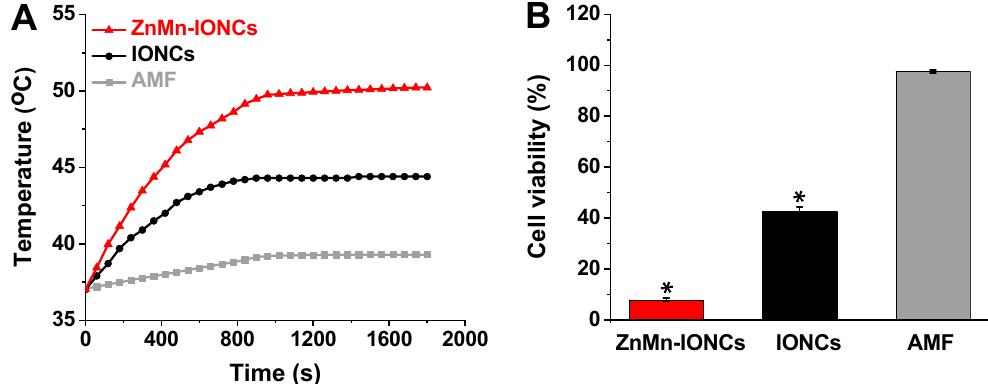
Figure 6. ( A ) Representative heating curves of DU145 cells treated with medium only (AMF), ZnMn-IONCs (50 µ g of Fe / mL) and IONCs (50 µ g of Fe / mL) for 24 h, and exposed to AMF (420 kHz, 26.9 kA / m). ( B ) The viability of DU145 cells treated with ZnMn-IONCs (50 µ g of Fe / mL), IONCs (50 µ g of Fe / mL) and medium (AMF) for 24 h and subjected to AMF for 30 min. * p < 0.05 when compared with untreated cells.